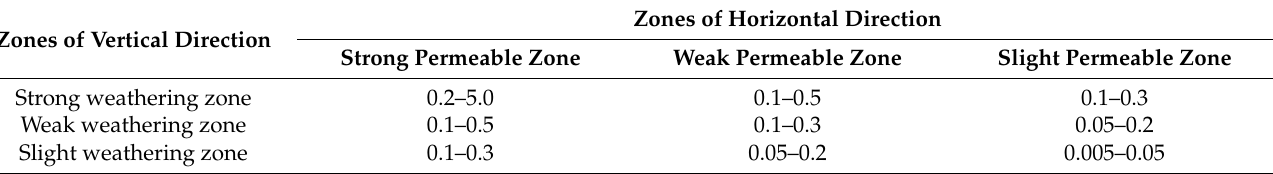
Figure 5. Different permeability zones in the study area. Table 5. Equivalent permeability coefficients for different zones (m/d).